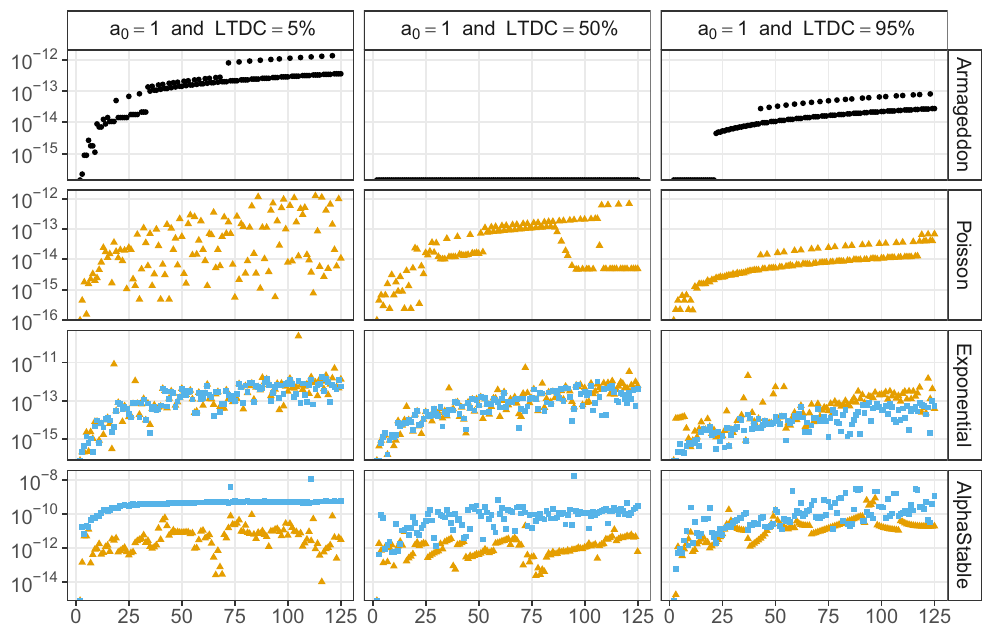
Figure 3: The maximum relative di ff erences ( ) ε d 1 of the o ff - diagonal row - sums for the proposed calculation of ∗ Q for ≤ ≤ d 2 50 ; coloring and shape indicate the used integral representation with none ( black, round ) , i.e., closed - form, Lévy ( yellow, triangle ) , and Stieltjes ( blue, square ) .